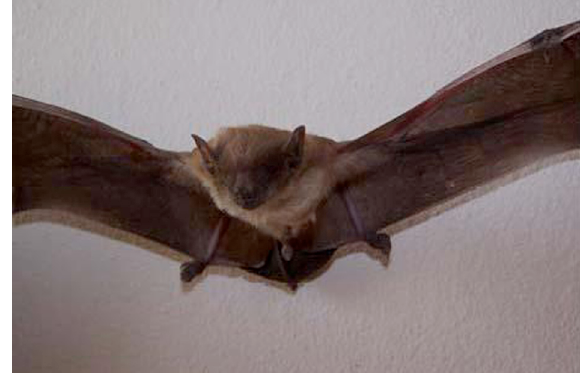
Table 1. External measurements (in mm) of Scotophilus kuhlii from Secunderabad